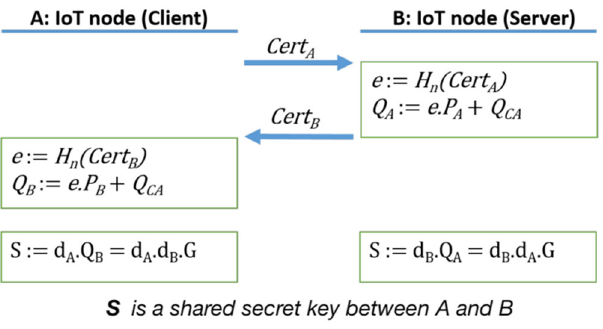
Figure 2. The ECQV implicit certificate-based authenticated key exchange algorithm [22].